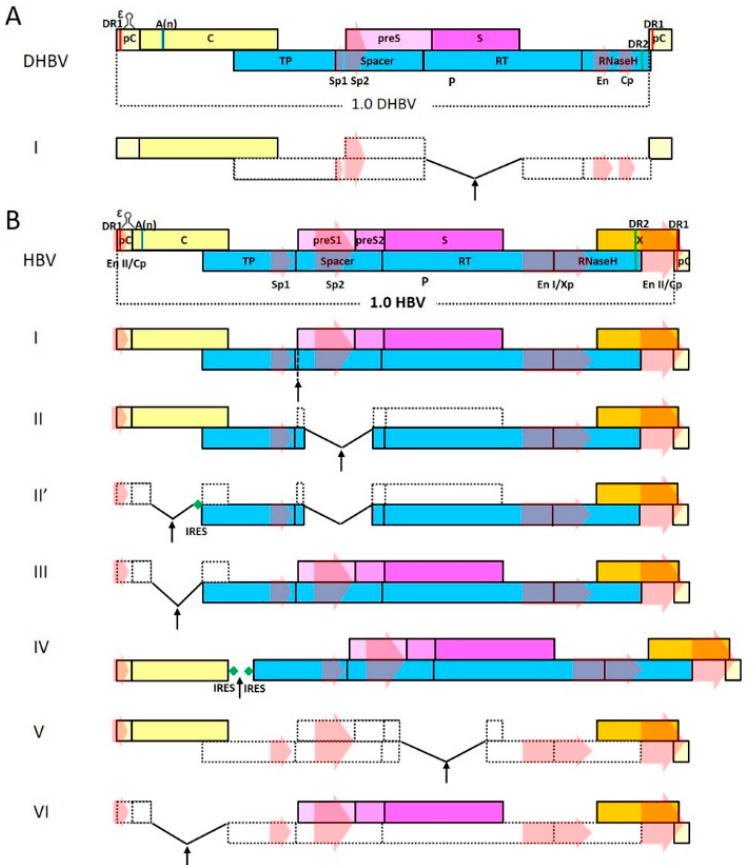
Figure 1. Schematic representation of genome organization of HBV and DHBV and major recombinant (D)HBV vector designs. Terminally-redundant wild-type genomes are shown to reflect the circularity and 1.0 copy of each genome is marked out beginning at the start codon of preC(pC)/C ORF. ORFs are represented by boxes and ORFs destroyed in recombinant vectors are depicted using dotted lines. Promoters (Cp, Sp1, Sp2, and Xp) and enhancers (En, EnI, EnII) are represented by arrows pointing in the direction of transcription. Cis elements required for replication and encapsidation are also depicted. ε , encapsidation signal. A(n), polyadenylation signal. DR, direct repeats. ( A ) Wild-type DHBV genome and recombinant DHBV design: I, cargo gene replaces S ORF in-frame and